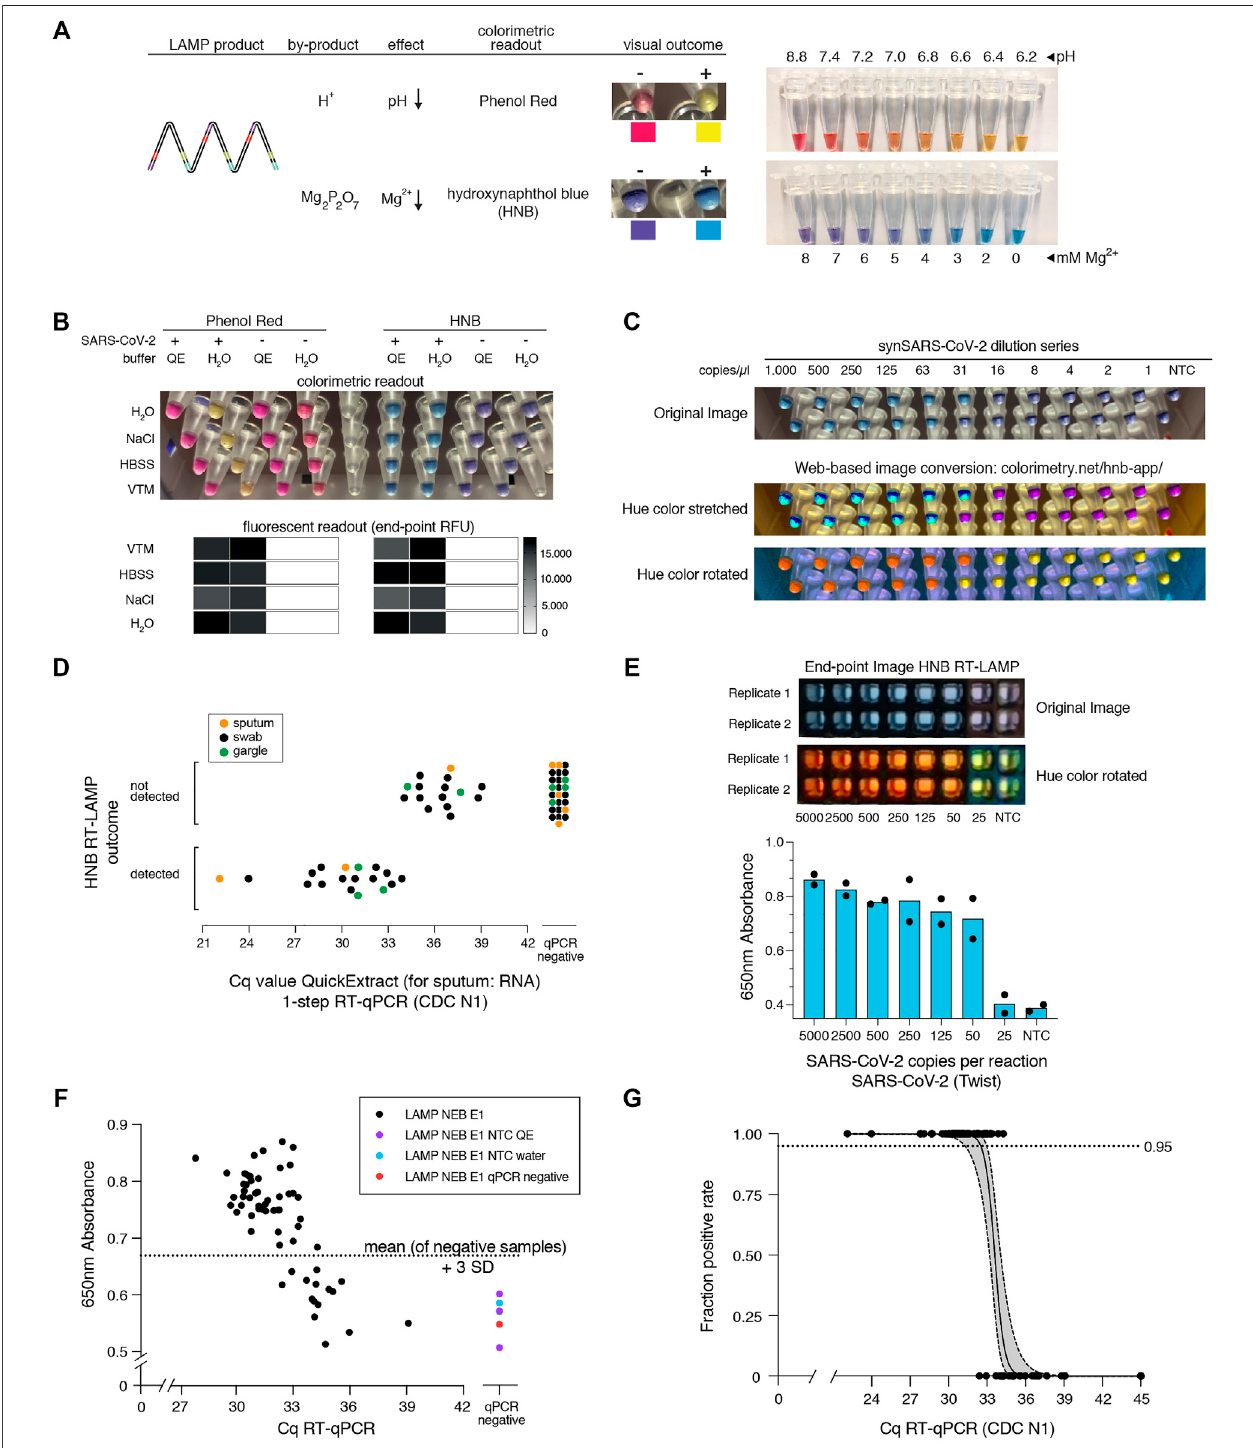
FIGURE 3 | HNB RT-LAMP enables colorimetric SARS-CoV-2 detection from crude patient samples. (A) Schematic illustrating the properties of pH-sensitive (Phenol Red, top) and Mg 2+ concentration sensitive (hydroxynaphthol blue, HNB, bottom) colorimetric readouts for LAMP. Phenol Red interacts with protons (H + ) generated during DNA ampli fi cation, which causes a color change from pink/red to yellow (right: the color range of the Phenol Red-containing colorimetric RT-LAMP mastermix (NEB) at relevant pH values). Magnesium pyrophosphate precipitate produced during DNA ampli fi cation lowers the free Mg 2+ concentration, causing a color change of the HNB dye from purple to sky-blue (right: the color range of solutions with HNB at relevant Mg 2+ concentrations). (B) In fl uence of QuickExtract on